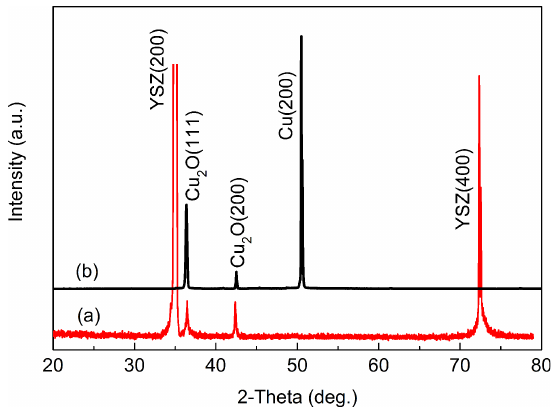
Figure 2: θ -2 θ XRD patterns of the as-prepared Cu 2 O films by differ- ent deposition methods, (a) MOD, (b)